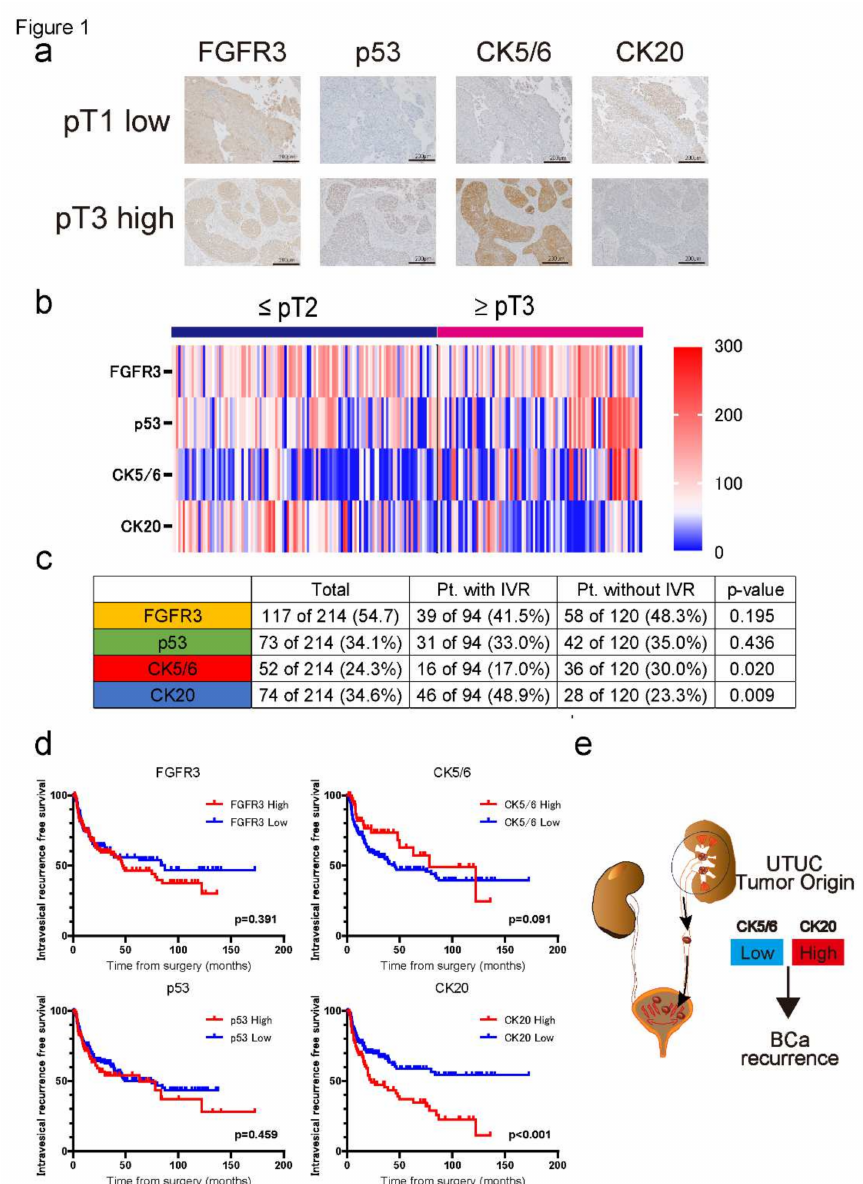
Figure 1. ( a ) Representative immunohistochemistry (IHC) staining of FGFR3, p53, CK5/6, and CK20 in surgical specimens; pTa low-grade upper tract urothelial carcinoma (UTUC) patients (upper panel) and pT3 high-grade UTUC patients (lower panel). The field scale bar = 200 µ m. ( b ) Heatmap describing the IHC score of FGFR3, p53, CK5/6, and CK20 in UTUC patients ( n = 214). Heatmap is divided by pT2 or low ( n = 116) and pT3 or high ( n = 98). The histoscore (H-score) was calculated by applying the following formula: mean percentage × intensity (range 0–300). ( c ) Table describing the rate of high expression group in each molecular biomarker. Expression rates were compared between patients who developed intravesical recurrence (IVR) and who did not develop IVR after radical nephroureterectomy (RNU). Chi-squared test was used to assess the significance of differences. ( d ) K–M curves comparing the IVR free survival rates in UTUC patients compared by low versus high FGFR3 expression, low versus high p53 expression, low versus high CK5/6 expression, and low versus high CK20 expression. Log-rank test was used to assess the significance of differences. ( e ) A schema describing the molecular characteristics of UTUC that are likely to develop IVR. As the multivariate analysis revealed, CK20 high and CK5/6 low expression tumor specimens were